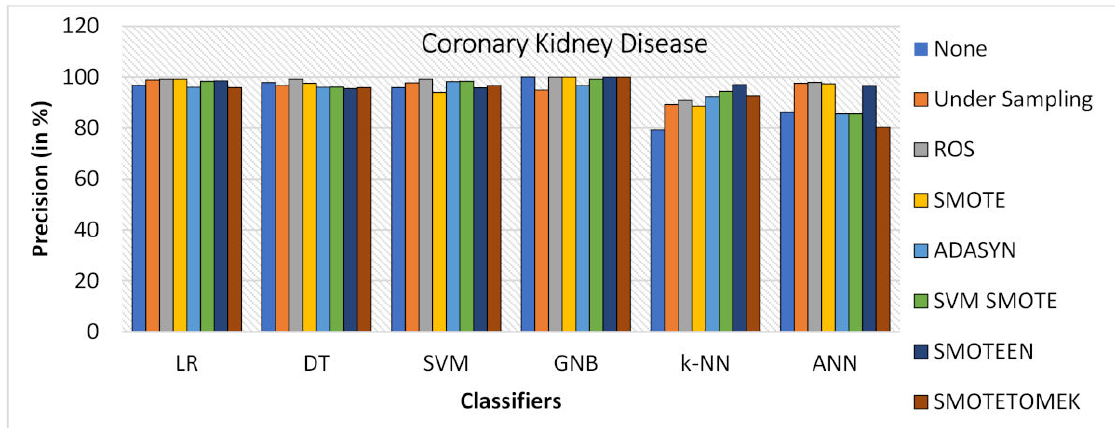
Figure 15. Precision for kidney disease dataset of balancing algorithms over six classifiers.